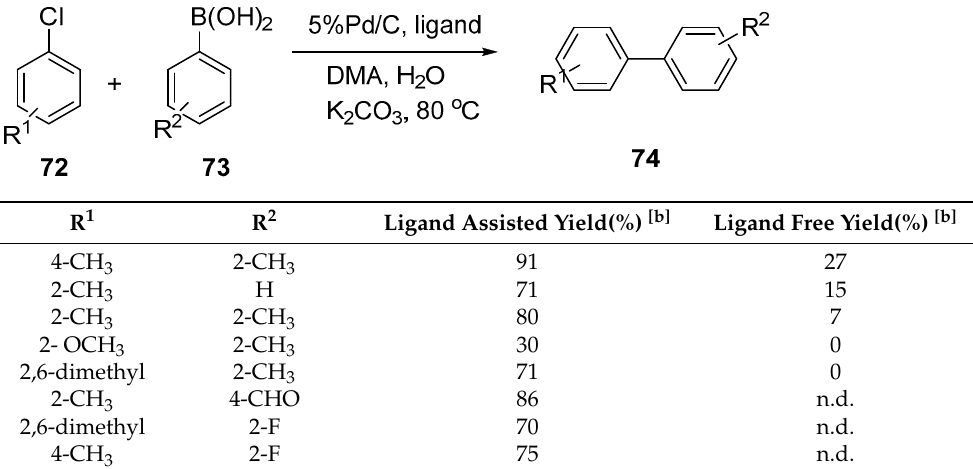
Table 3. Ligand-free versus XPhos-assisted Pd/C-catalyzed Suzuki–Miyuara cross-couplings of aryl chlorides [a] .